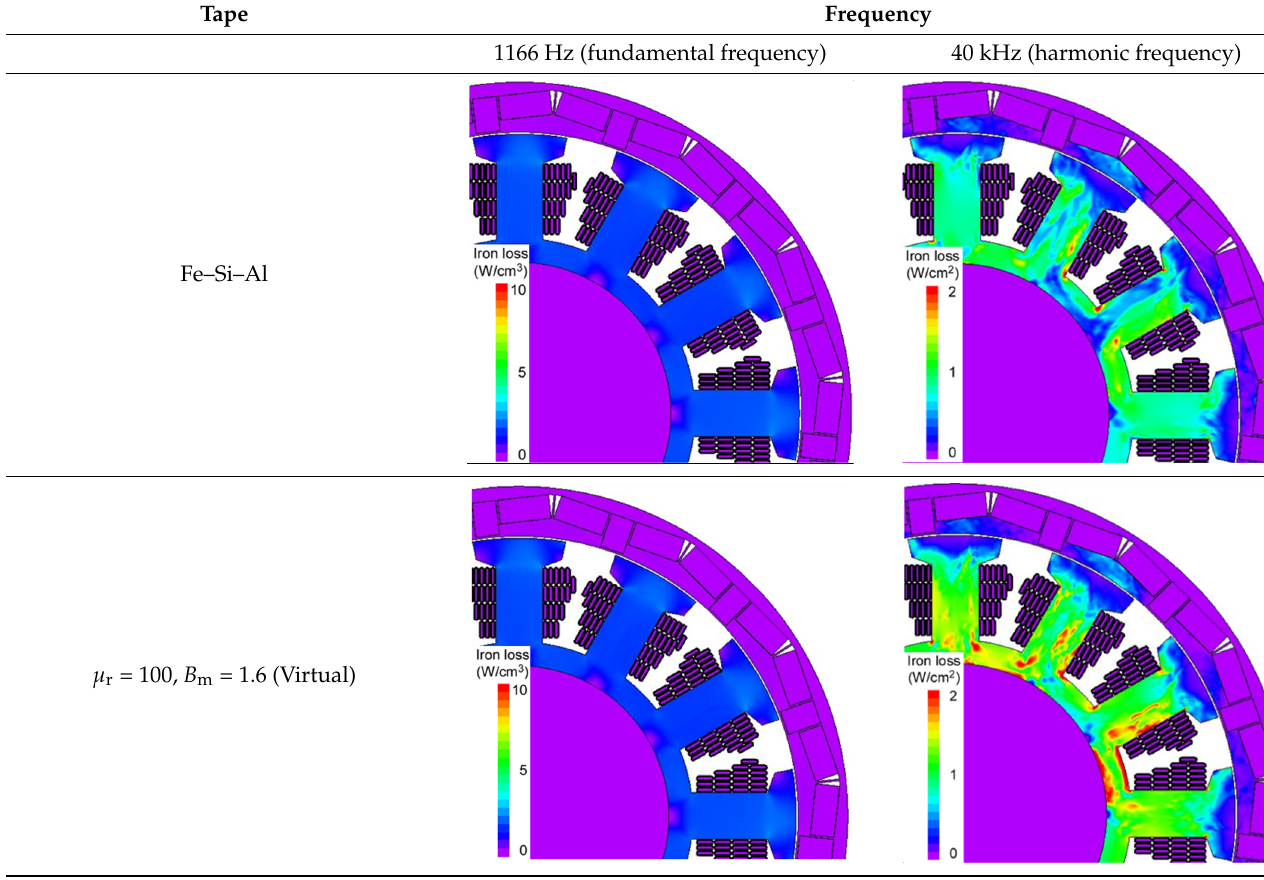
Table 2. Iron loss distributions at different frequencies ( P o = 10 kW, N r = 10,000 rpm, ripple = 100%).